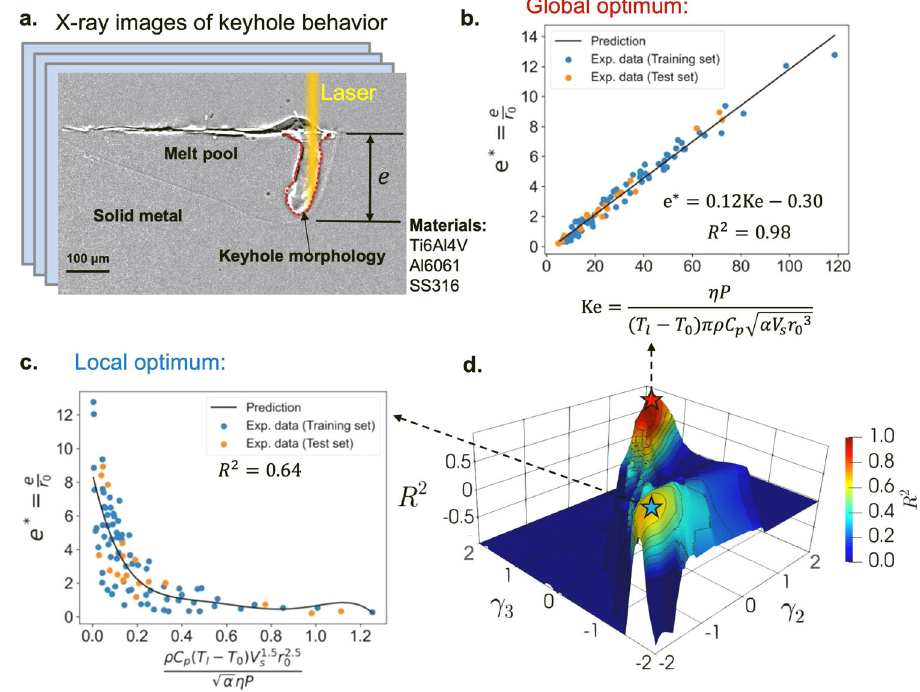
Fig. 2 | Discover dimensionless numbers governing keyhole dynamics in laser – metal interactions. a An illustrative X-ray image of keyhole morphology 28 . The dataset includes X-ray imaging experiments on three different materials. b Global optimum of the dimensionless space, which represents the scaling law between the keyhole aspect ratio and the identi fi ed keyhole number using